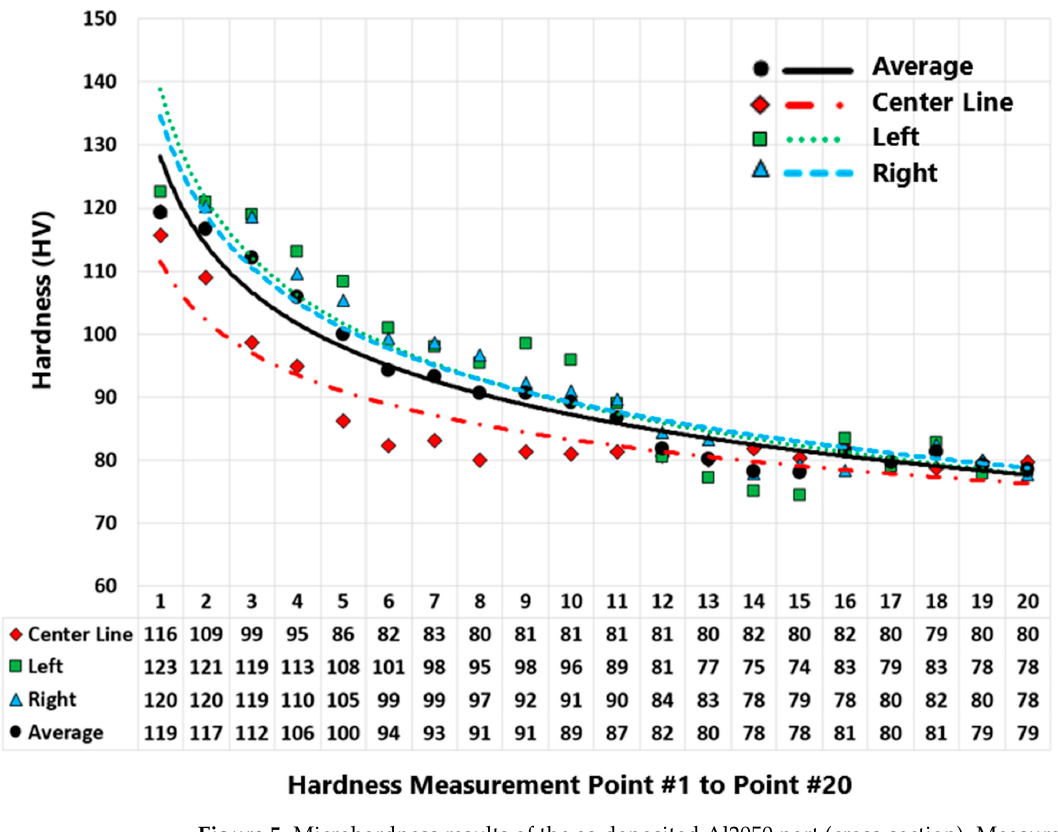
Figure 5. Microhardness results of the as-deposited Al2050 part (cross-section). Measurements along three lines, namely, center, left, and right lines (Figure 4).